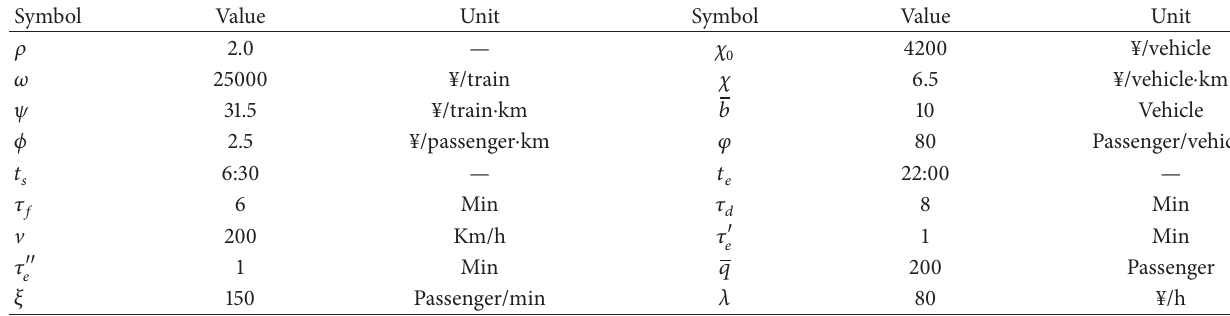
Table 1: Parameter values of model (M1).